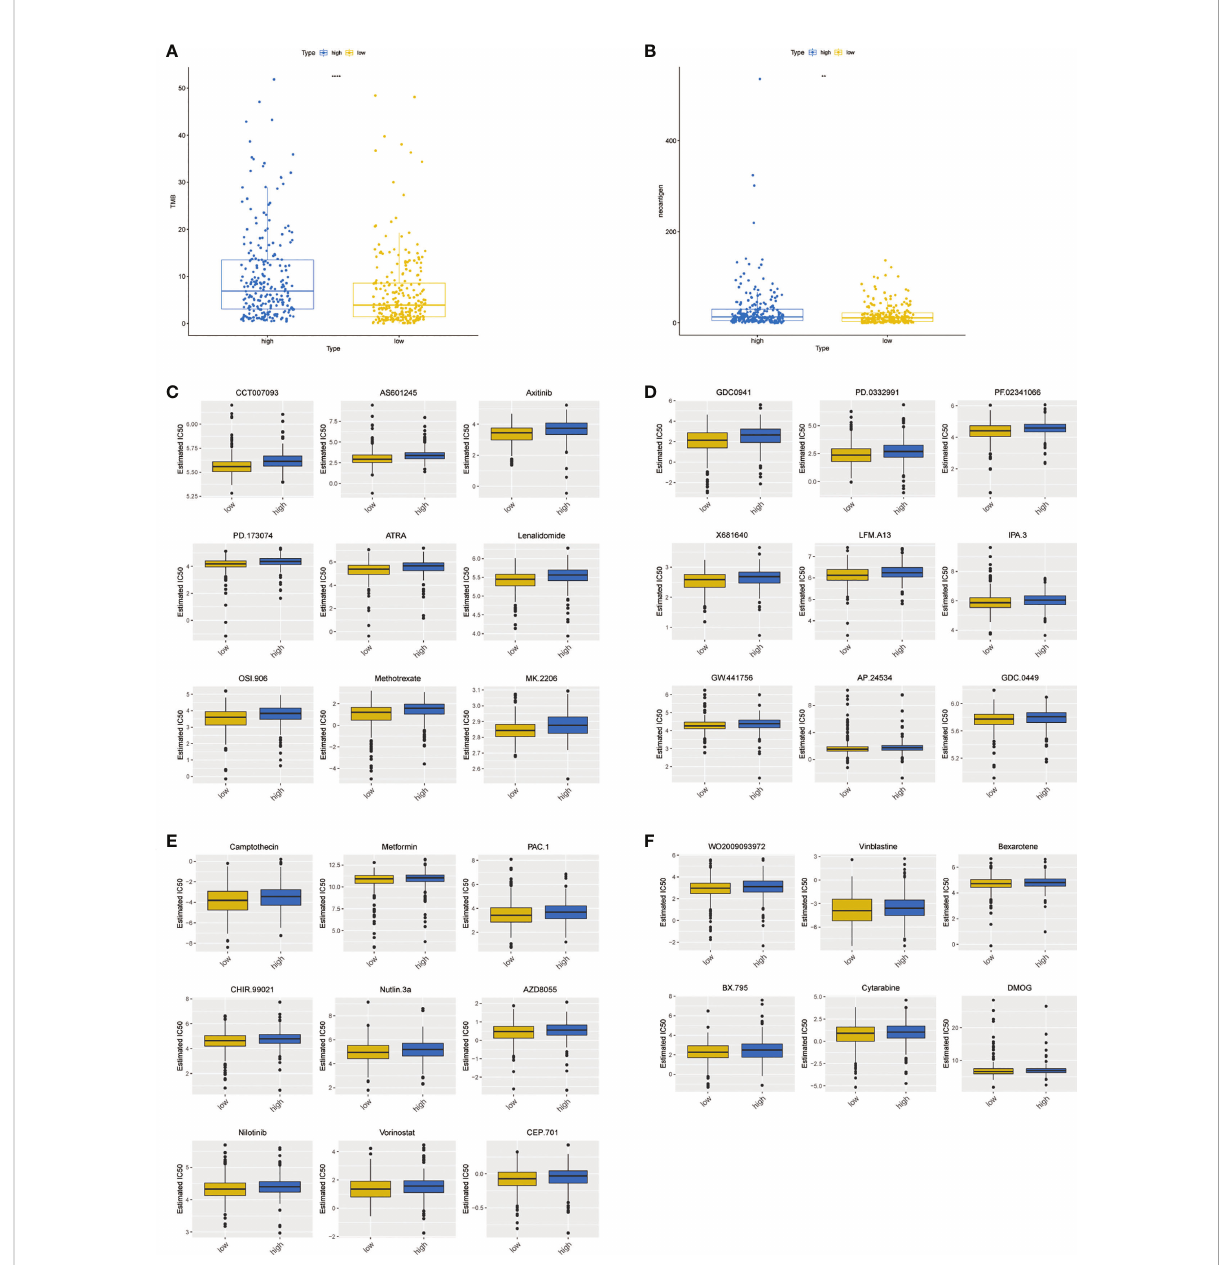
FIGURE 9 Differences in TMB levels, neoantigen levels, and chemotherapy drug sensitivity between high- and low-risk groups. (A) Boxplot of the TMB between high- and low-risk groups. (B) Boxplot of the neoantigen values between high- and low-risk groups. (C – F) Boxplot of 33 chemotherapy drug sensitivity between high- and low-risk groups. ** represents P < 0.01, **** represents P <